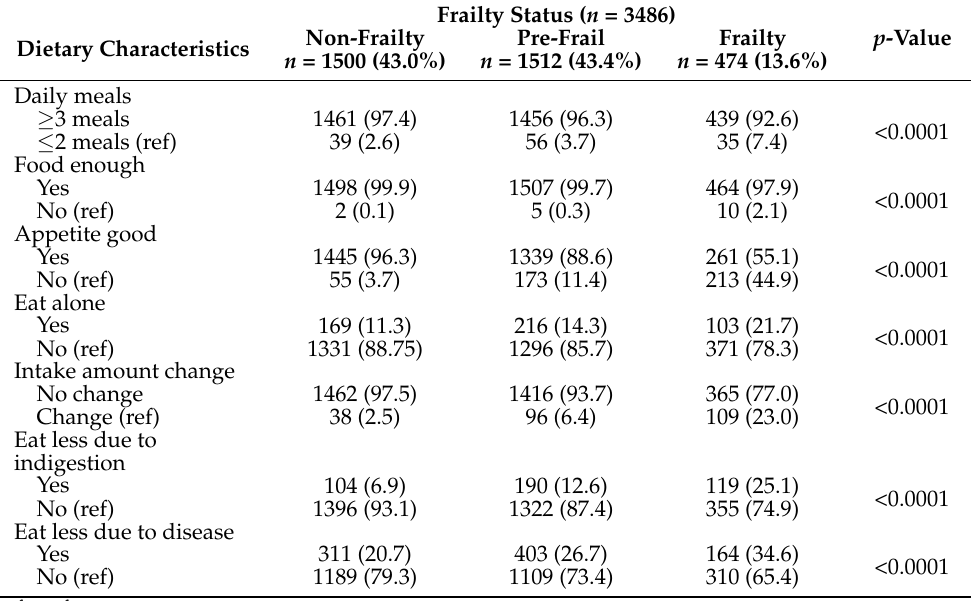
Table 3. Baseline (1999) dietary characteristics stratified according to frailty status.